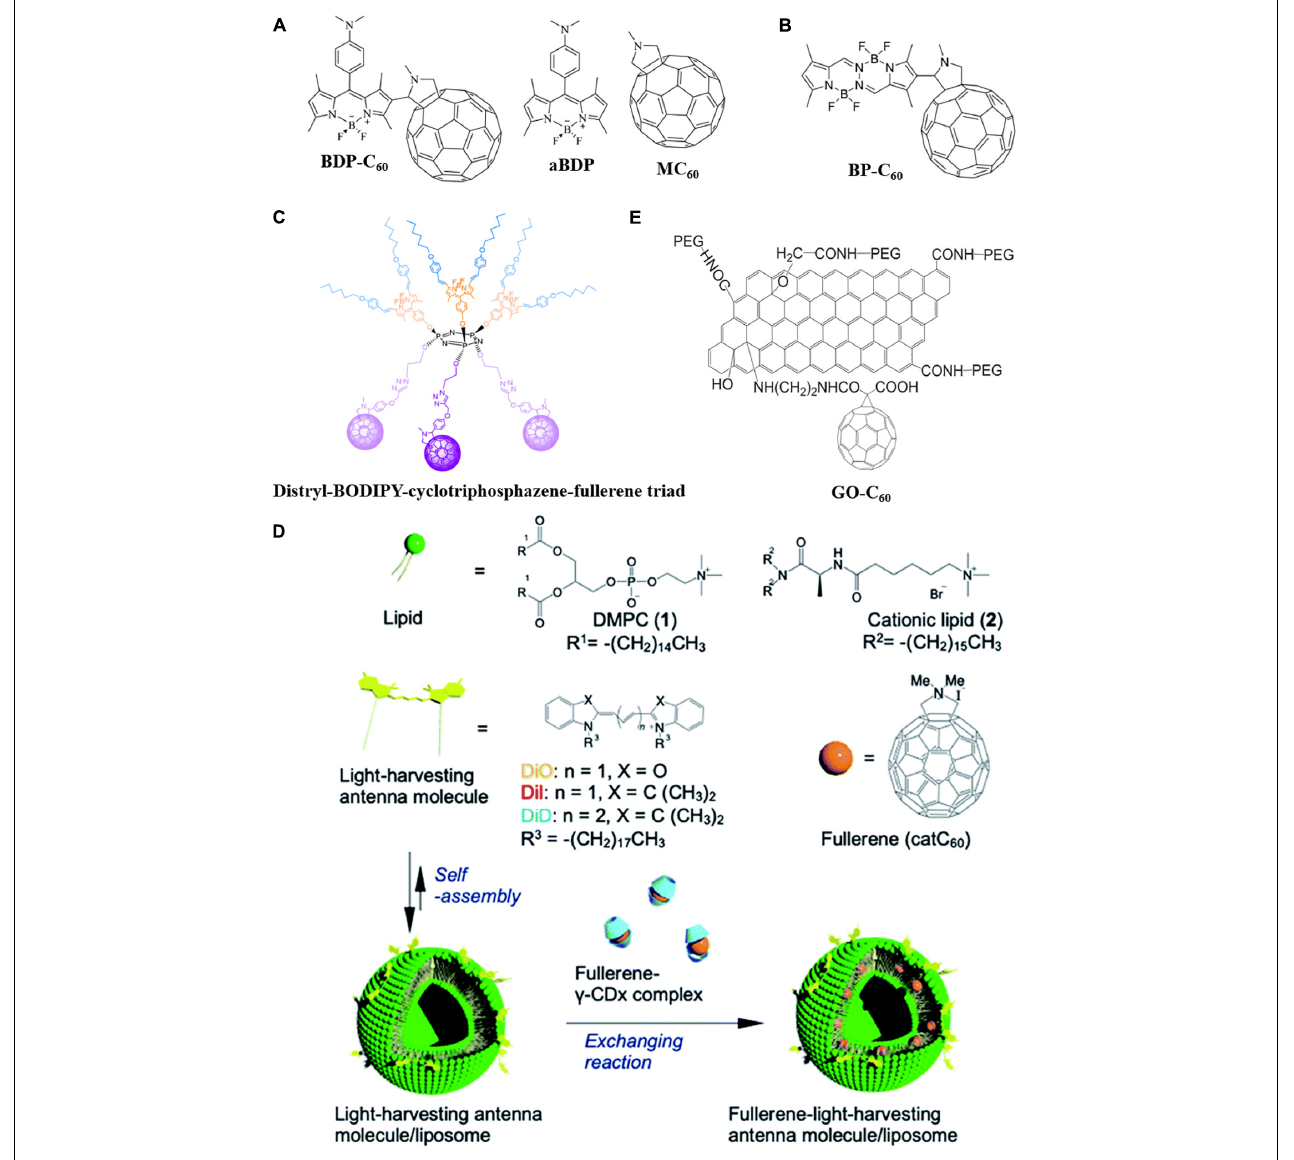
FIGURE 5 | Molecular structures of the fullerene derivatives with a light-harvesting antenna. (A) BDP-C 60 , aBDP, and MC 60 (Agazzi et al., 2019b). (B) BP-C 60 (Lopez et al., 2021). (C) Distryl-BODIPY-cyclotriphosphazene-fullerene triad (Sarikaya et al., 2019). (D) Schematic diagram of LMIcatC 60 –light-harvesting antenna molecules (Kawasaki et al., 2020). (E) GO-C 60 (Li et al.,